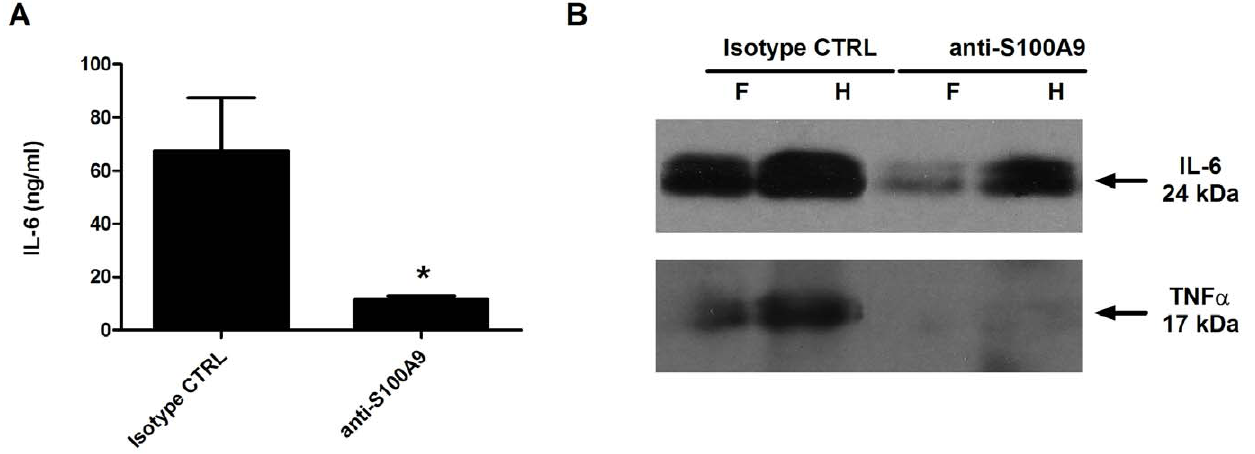
Figure 5. S100A9 treatment decreases the secretion of pro-inflammatory cytokines (A) 5 days after LPS injection, sera were collected and tested for IL-6 by ELISA. Values are the mean 6 SEM of 10 mice. *p , 0.05, t test (n=10 serum samples/group) (B) Thirty micoliters from a pool of 5 paw homogenates were separated by sodium dodecyl sulfate polyacrylamide gel electrophoresis and tested for the presence of IL-6 and TNF- a . F: forepaw, H: hind